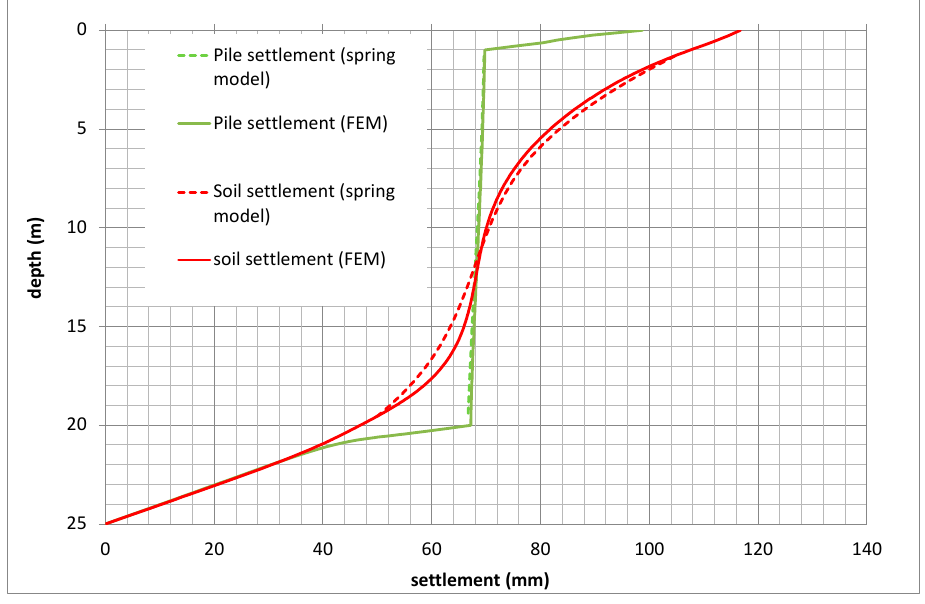
Figure 10. Pile and soil settlement comparison.